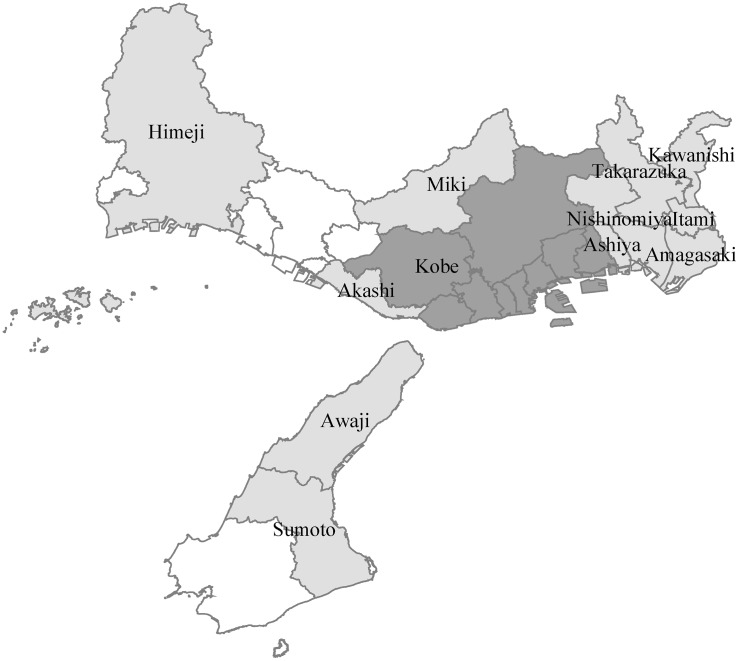
Hyogo Prefecture.